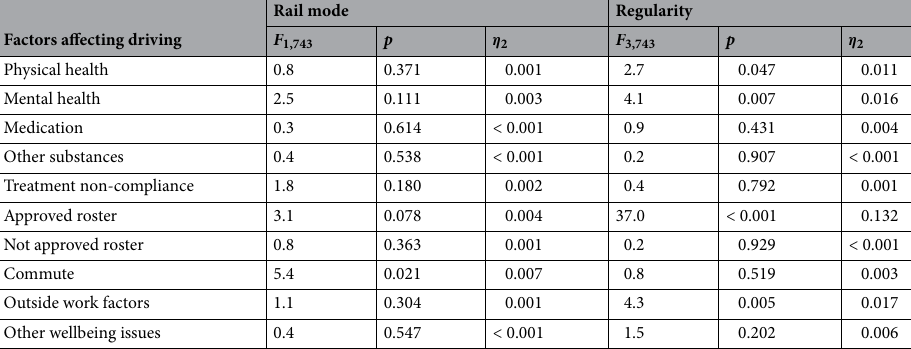
Table 3. MANCOVA post-hoc investigation of rail mode and regularity, controlling for age, gender, days per week, shift length, and shift pattern. Comparisons for mode (freight = f, passenger = p)—commute (p > f); Comparisons for regularity (regular = 1, somewhat = 2, irregular = 3, very irregular = 4)—physical health (4 > 1), mental health (4 > 1), approved roster (4 > 3 > 2 > 1), outside work factors (4 > 1).